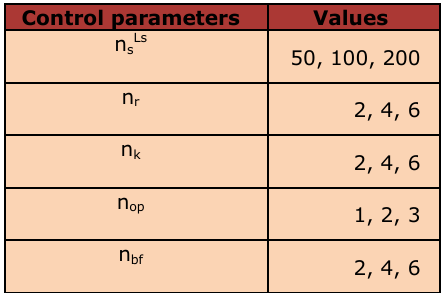
Table 1. Control parameter value